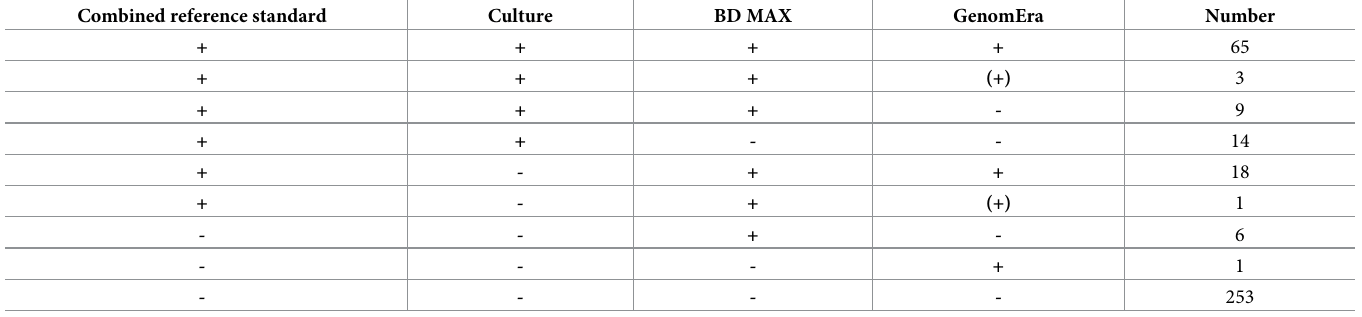
Table 5 shows the performance of cultures of GBS, BD MAX GBS and GenomEra GBS compared to the combined reference standard. Differences in sensitivity, specificity and pre- dictive values between vaginal culture, BD MAX GBS and GenomEra GBS were not statisti- cally significant. Table 4. PCR results with combined standard as